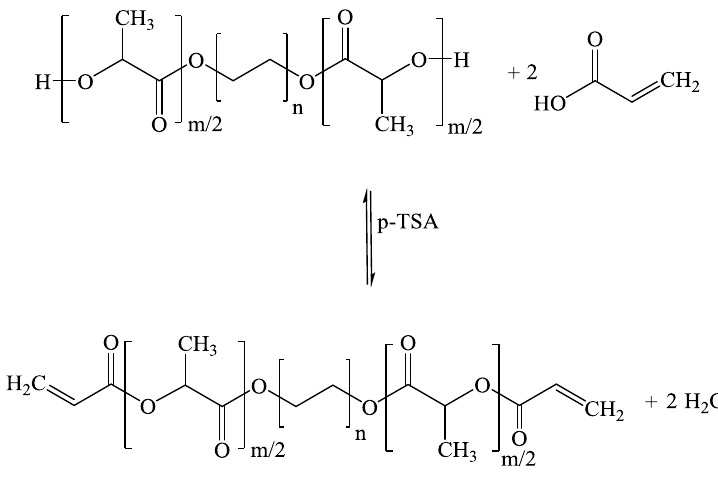
Figure 4. Acrylate functionalization scheme of an oligolactide diol with acrylic acid.